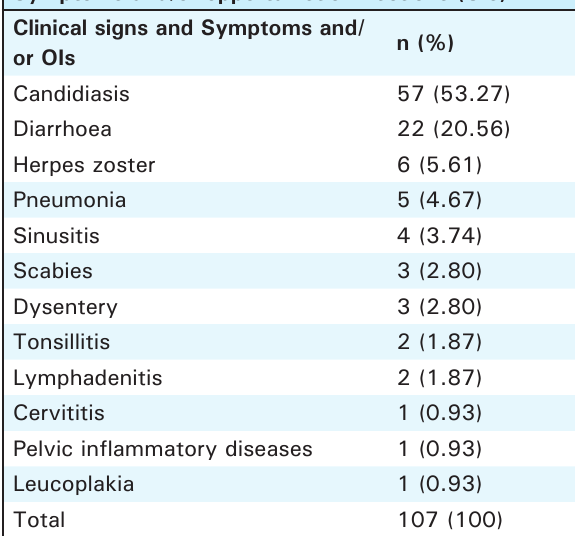
Table 6. Distribution of patients by clinical signs and Symptoms and/or opportunistic infections